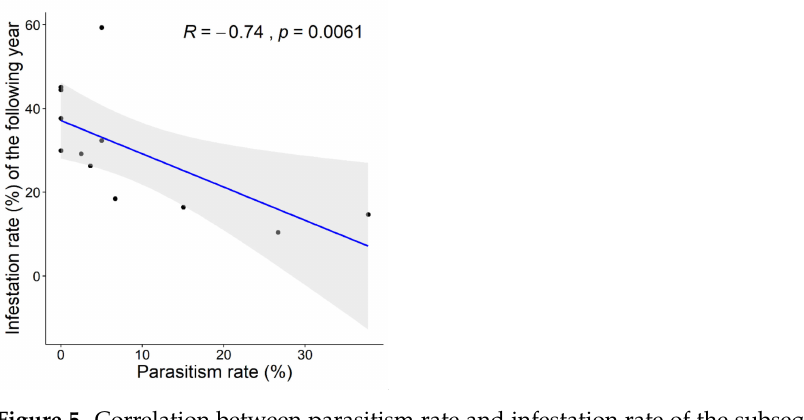
Figure 5. Correlation between parasitism rate and infestation rate of the subsequent D. oleae gen- eration; the correlation test was performed using Spearman rho rank. The blue line and the 95% confidence interval (gray area) show the linear regression. Each point corresponds to the medium value of each orchard’s parasitism and infestation